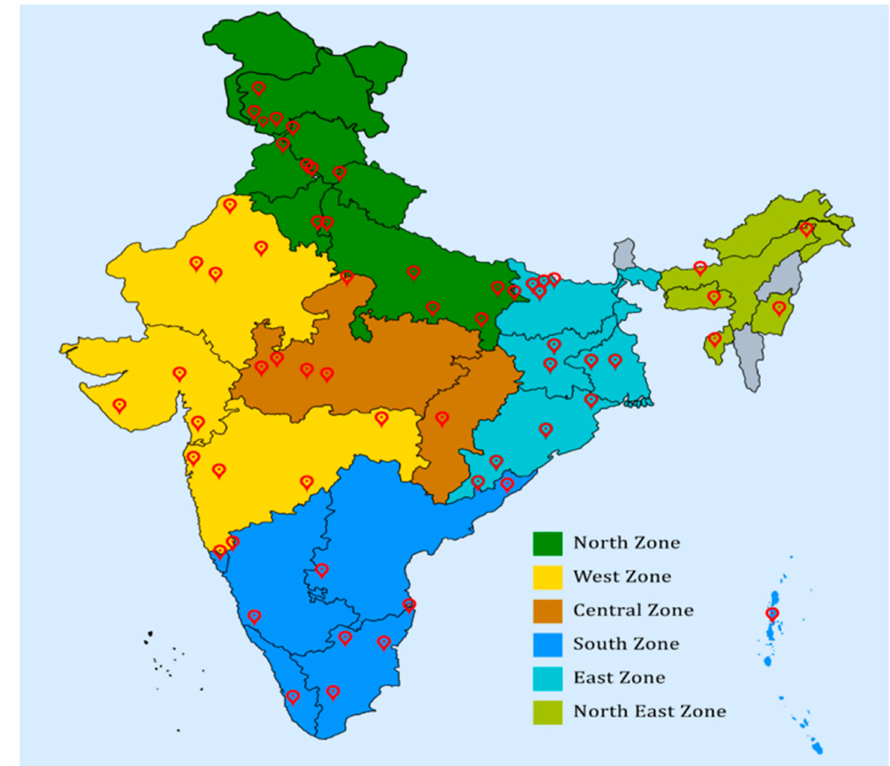
Figure 1. Representing six di ff erent zones of